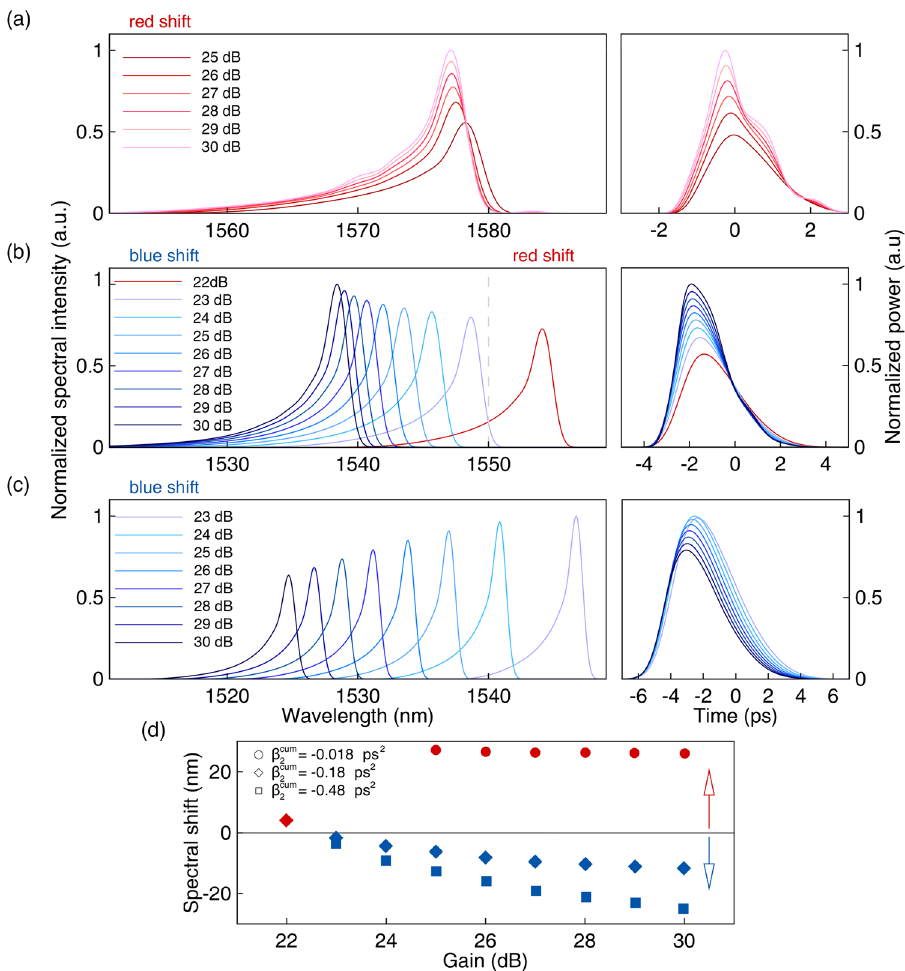
Figure 9. Spectral (left) and temporal (right) profiles of the steady-state pulses for different cavity dispersion and small-signal gain (marked on the figures): ( a ) β 0.48 ps 2 . ( d ) Spectral shift of the generated pulse from the central wavelength of the optical filter for β cum 2 = − varying small-signal gain parameter h 0